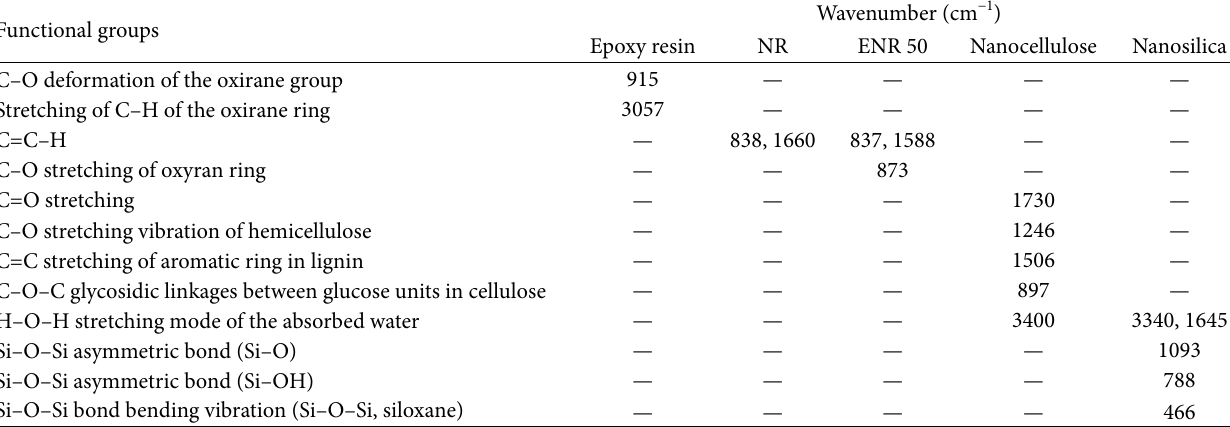
Table 1: Comparing the FTIR spectras of raw